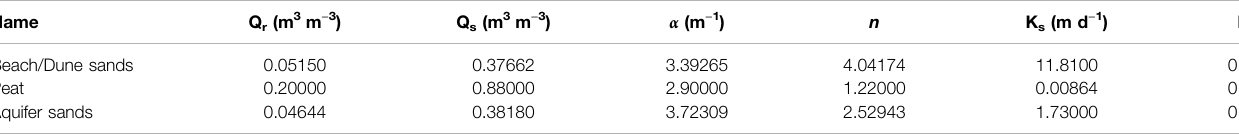
TABLE 1 | Soil hydraulic parameters used in the standard scenario.